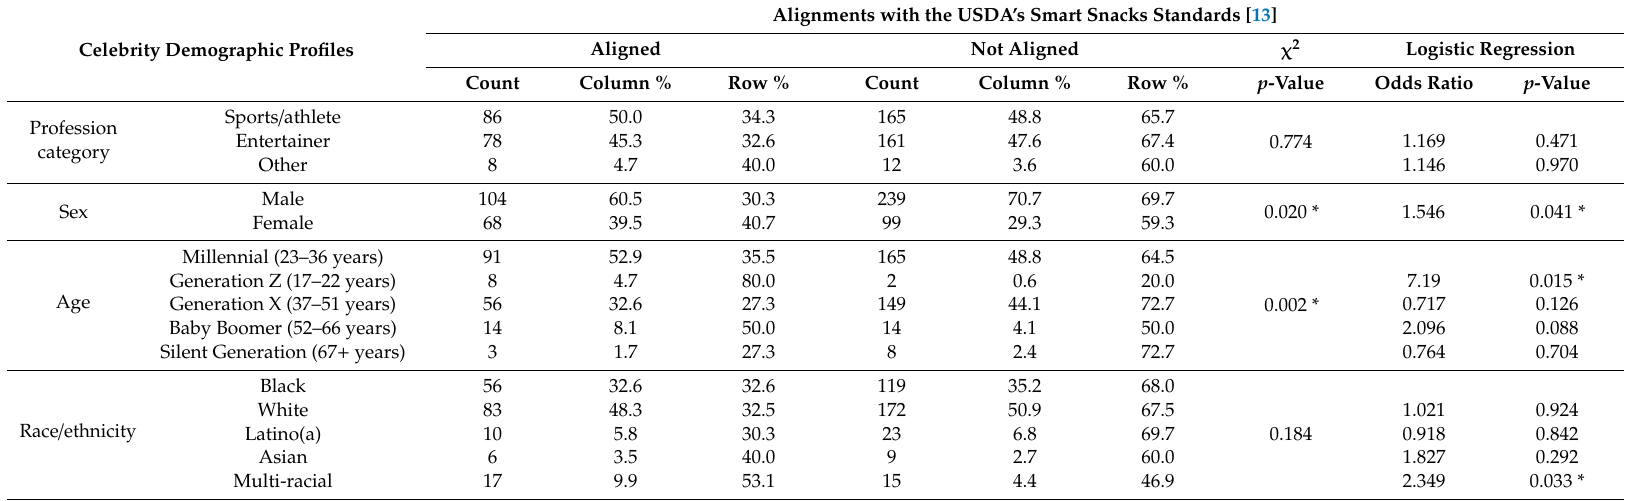
Table 6. Associations between celebrity demographic profiles and the nutritional profiles of food and beverage product or brand endorsements ( n = 510).